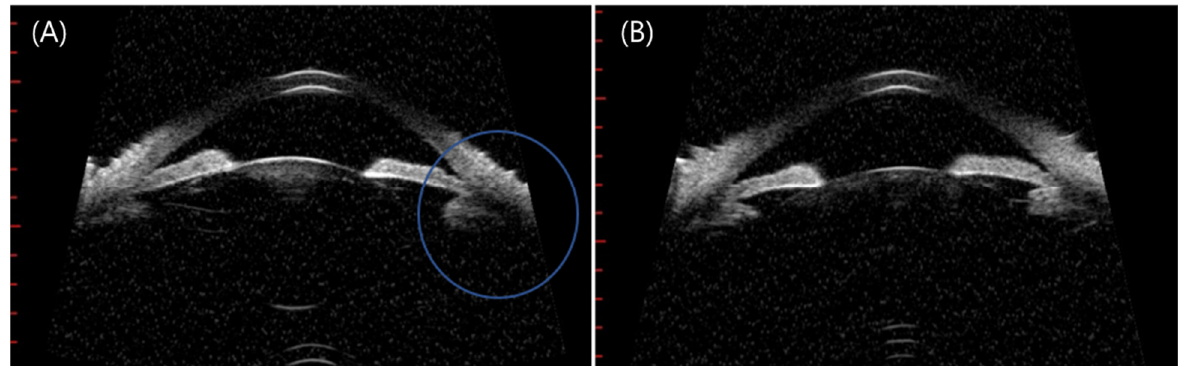
Figure 4. (Patient 17) ( A ) Right eye of a 64-year-old man, who had no previously diagnosed disease. He visited our clinic complaining of pain and redness in the right eye 6 days after AZD1222 inoculation. ( B ) His left eye shows a normal peripheral angle and no zonule laxity. His initial IOP was 34 mmHg associated with shallowing of the anterior chamber peripherally in the right eye. His bio-microscopy images show anterior bowing of the peripheral iris and ciliary swelling in the right eye than the left eye, which caused phacodonesis of the right eye and closure of the iridocorneal angle in the right eye. An acute attack of angle closure was diagnosed, treatment with laser peripheral iridotomy was attempted, and his IOP dropped to 10 mmHg.